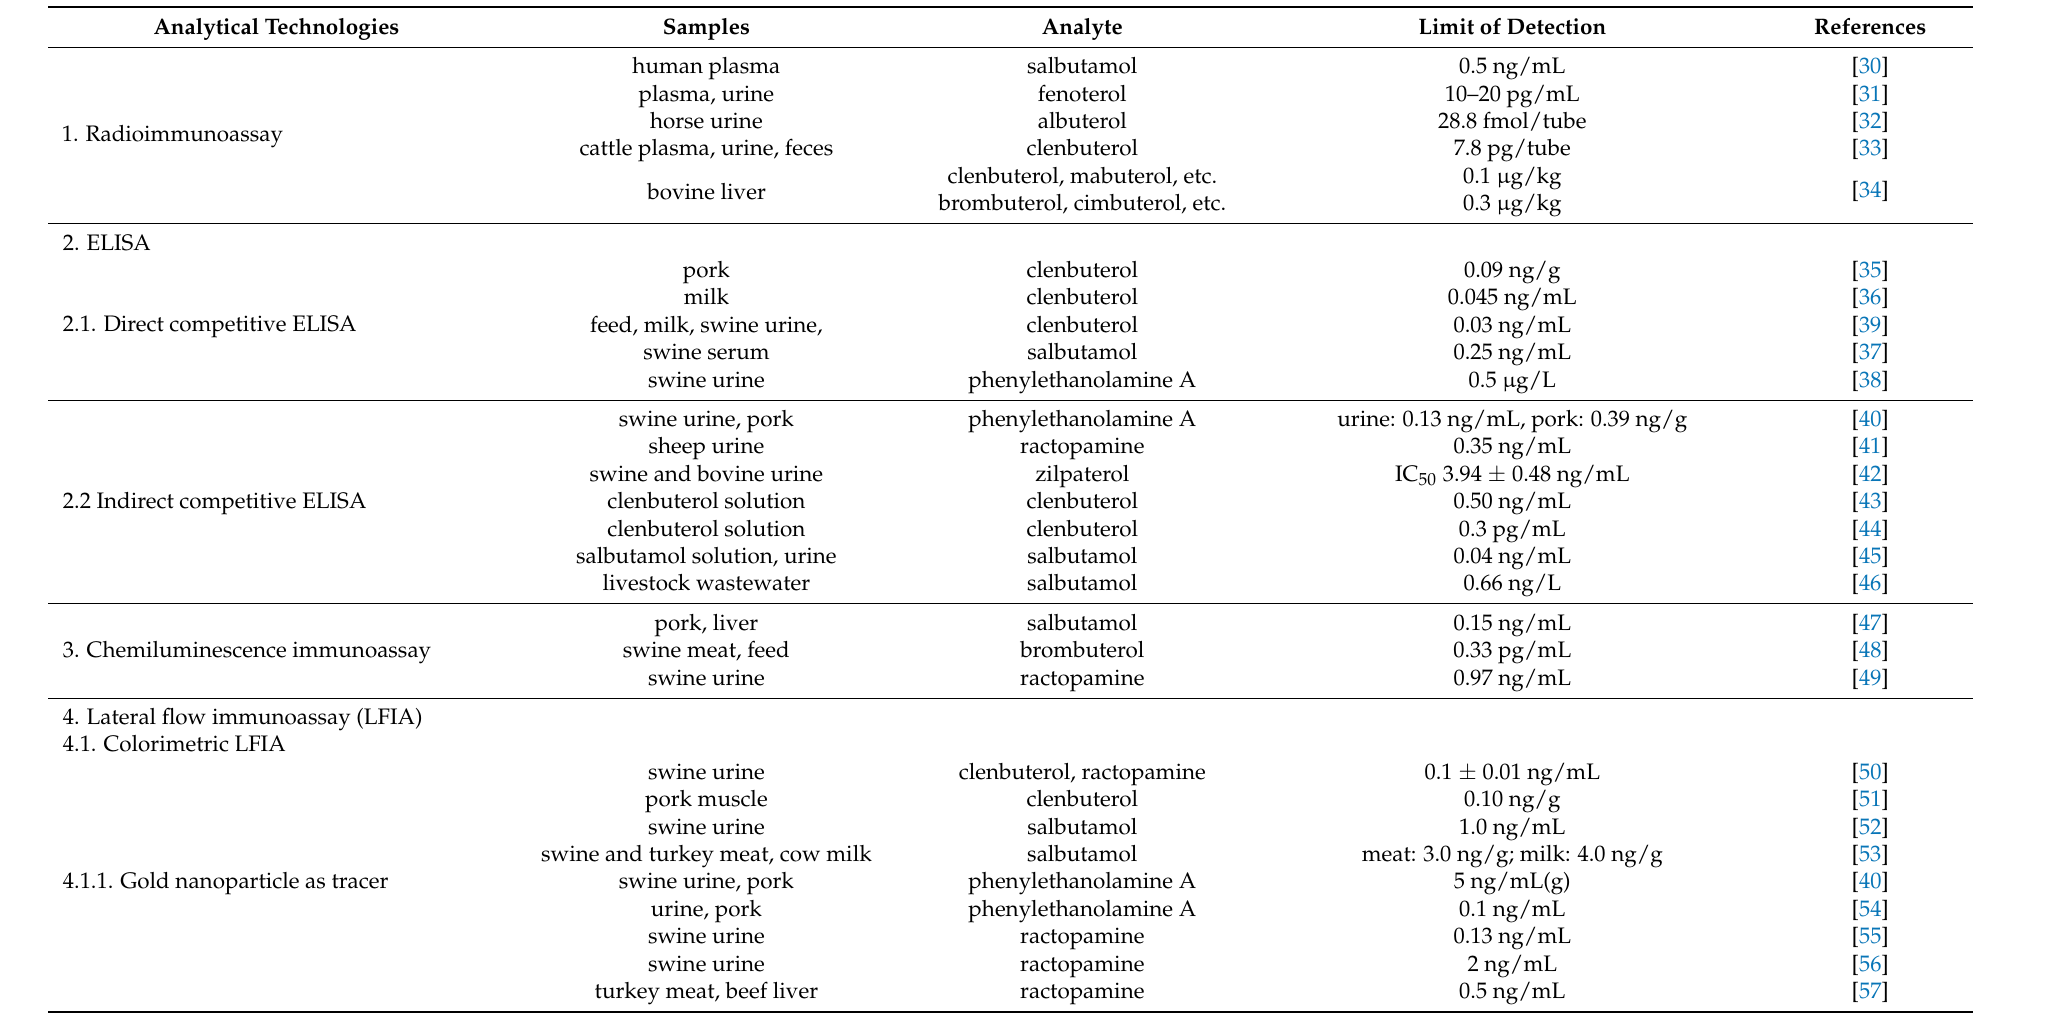
Table 2. Immunoassays for the detection of β 2